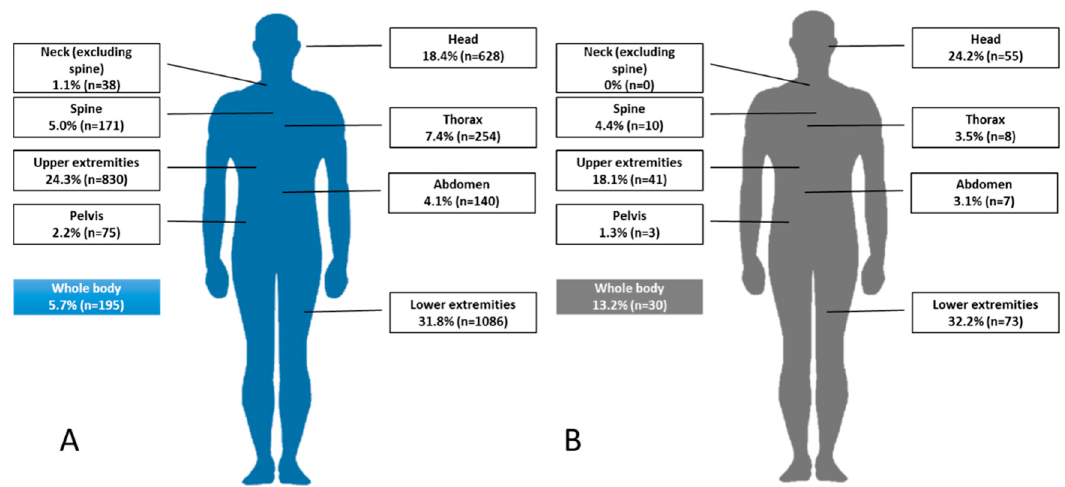
Figure 7. The number of injuries to body parts for a: ( A ) motorcycle driver; ( B ) passenger [49].